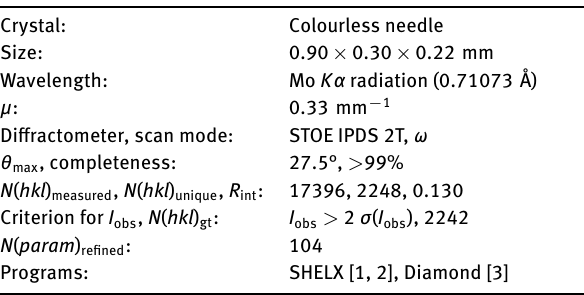
Table 1: Data collection and